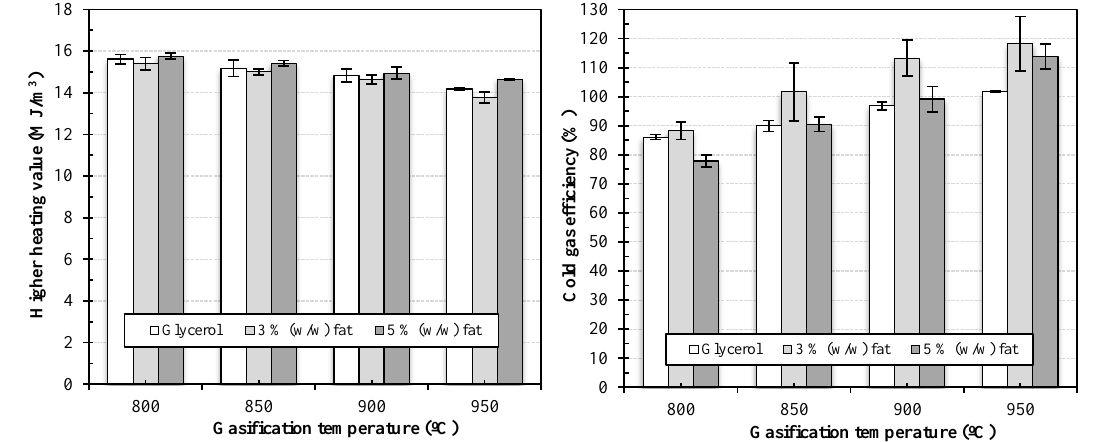
Figure 10. E ff ect of the addition of fat on producer gas higher heating value and cold gas e ffi Figure 10. Effect of the addition of fat on producer gas higher heating value and cold gas efficiency.